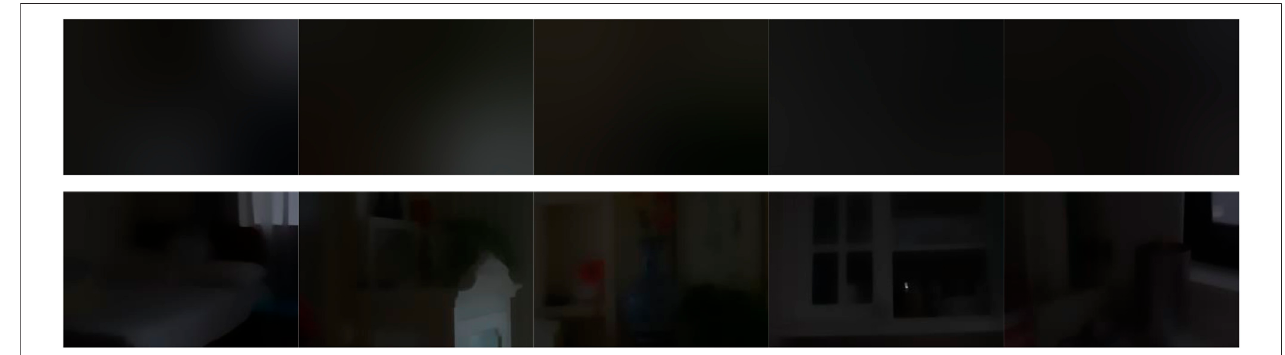
FIGURE5 | The fi rstrow is theirradiation component obtained by Gaussian kernel function; thesecond row istheirradiation componentobtained by thestructure extraction from texture via relative total variation method.